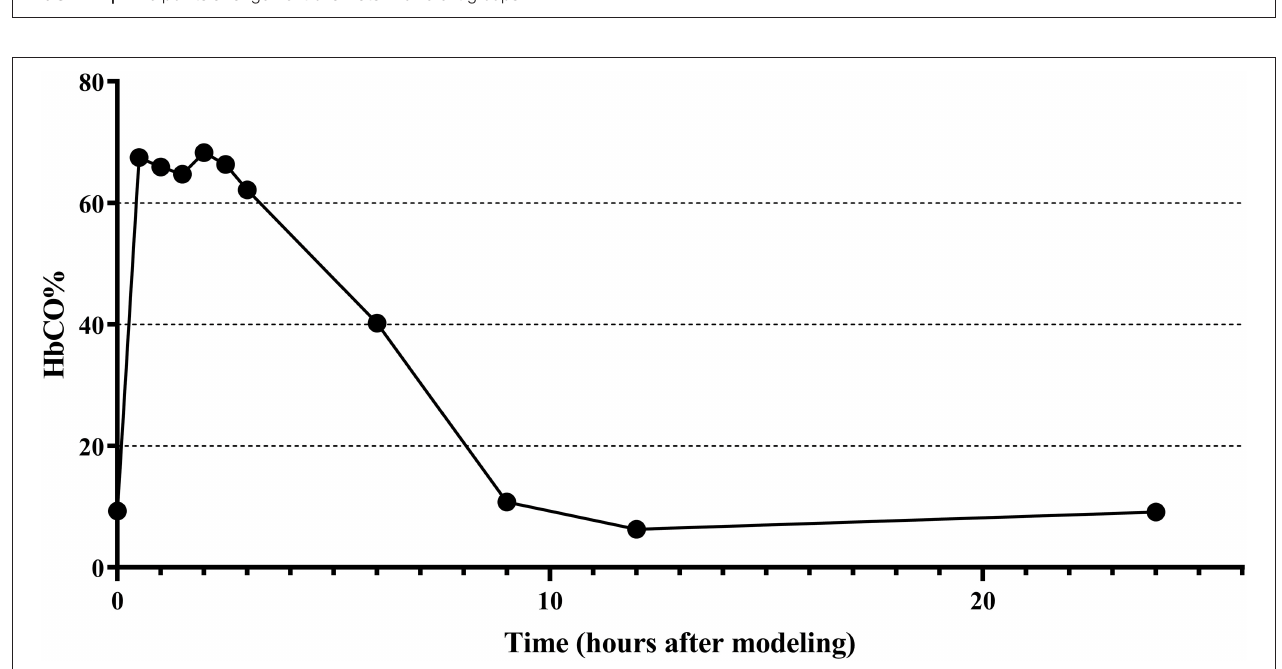
FIGURE 2 | Changes of HbCO% in left ventricular blood of rats before and after CO